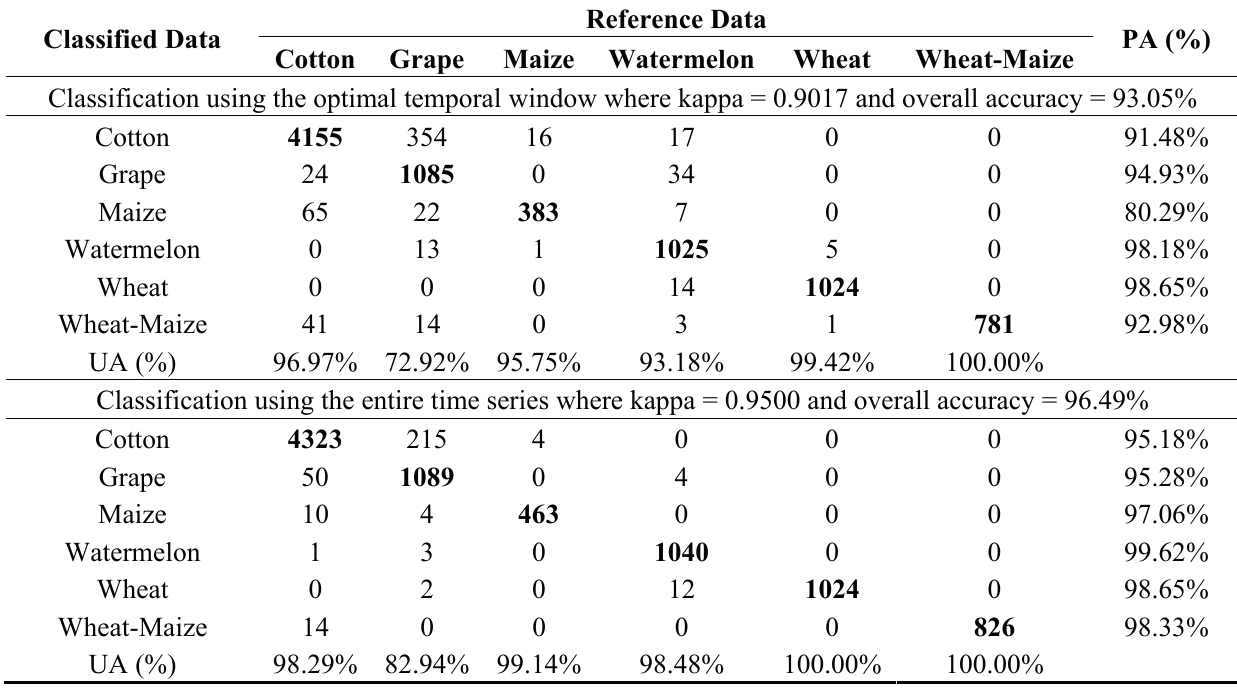
Table 8. Evaluation of crop classification performance in the Bole study area for the entire time series and optimal temporal window using the SVM classifier.